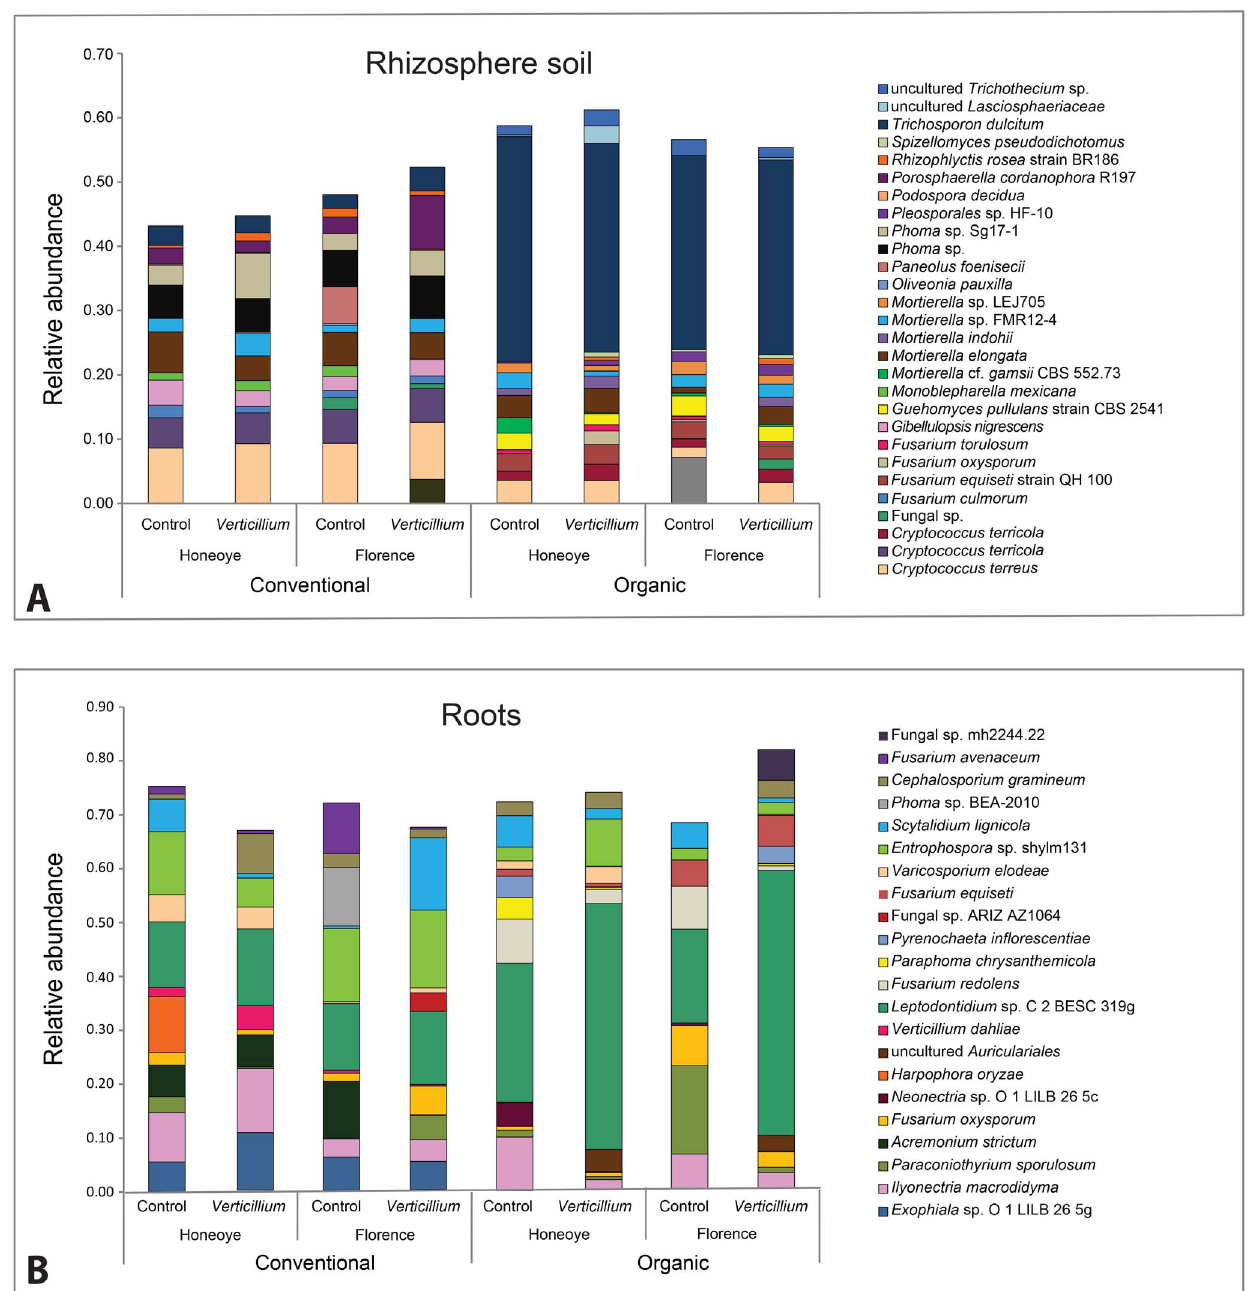
Figure 4. The top ten fungal operational taxonomic units (OTUs) (according to Similarity Percentage analysis) (SIMPER) contributing to the observed differences between control and Verticilliumdahliae treatments in Honeoye and Florence grown in conventionally and organically managed soils. A) Rhizosphere soil (29–39%), B) Roots (61–74%).